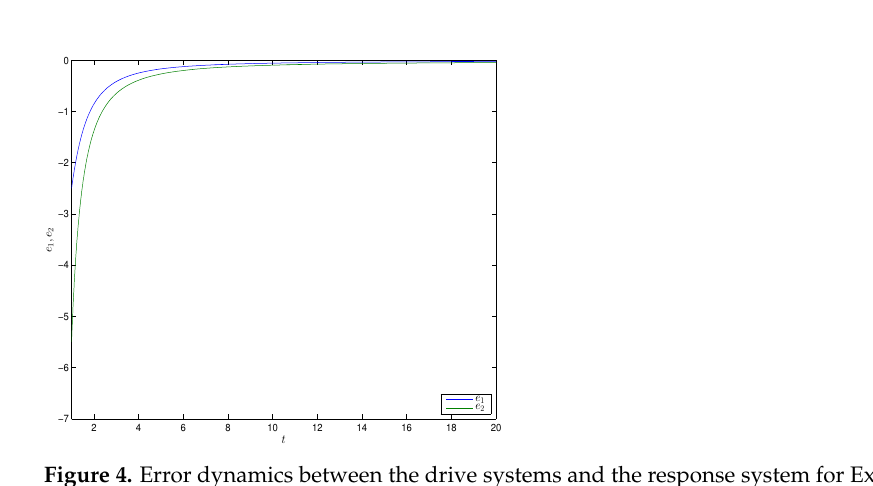
Figure 4. Error dynamics between the drive systems and the response system for Example